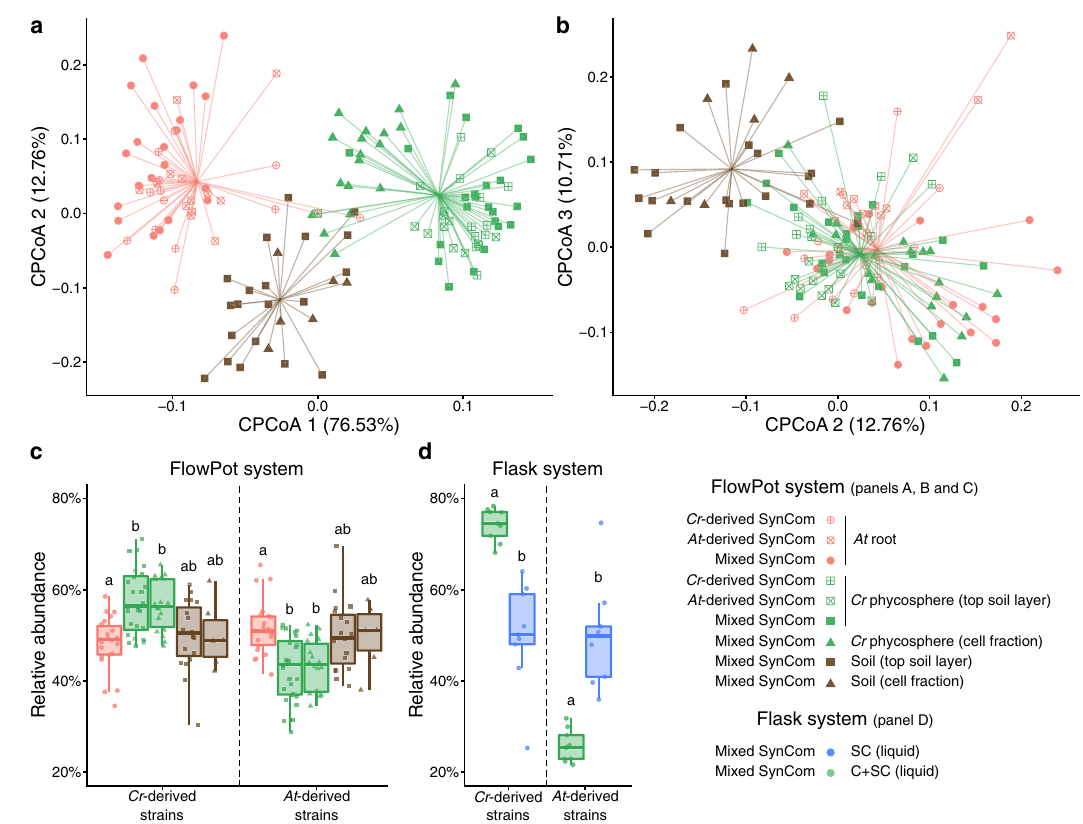
Fig. 5 Root and phycosphere bacteria colonize At and Cr and assemble into taxonomically equivalent communities. a Strain-level beta diversity analysis of soil ( n = 26), root ( n = 57), and phycosphere ( n = 66) bacterial community pro fi les, from gnotobiotic At and Cr , inoculated with bacterial SynComs derived from At roots ( At -SPHERE), Cr ( Cr -SPHERE), or mixed ( At - and Cr -SPHERE), grown in the FlowPot system. b CPCoA of Bray – Curtis dissimilarities of the same samples, aggregated at the bacterial family level (6.4% of the variance; P < 0.001). c , d Aggregated relative abundances of At - and Cr -derived strains in the mixed SynCom in a soil-derived ( n = 149, c ), a n d liquid-based ( n = 18, d ) gnotobiotic system. A Kruskal – Wallis test followed by a Dunn ’ s post hoc was used to assess signi fi cant differences among groups ( P < 0.05). Corresponds to experiment G (Supplementary Fig. 1g and Supplementary Table